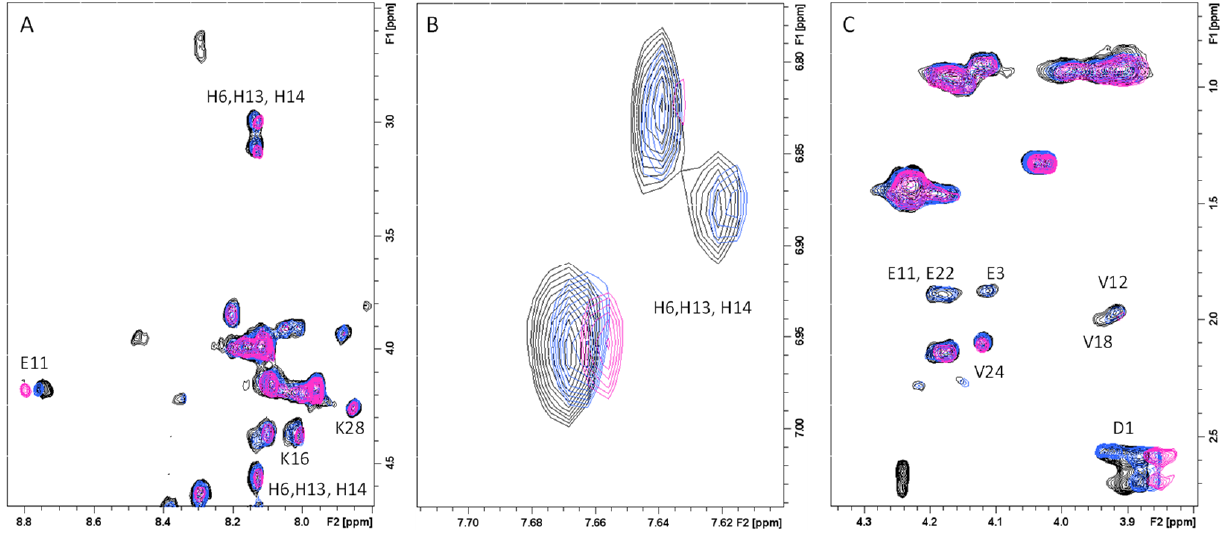
Figure 3. Selected regions, ( A) fingerprint region; ( B ) aromatic region; ( C ) aliphatic region, of 1 H ‐ 1 H TOCSY spectra of A β 40 in absence (magenta contours) and in presence of 0.8 eqs. of GAL (blue contours) and LYC (black contours). A β 40 concentration 0.18 mM, EtOD(60)/H 2 O(40) (phosphate buffer 20 mM) mixture, T = 298 K.